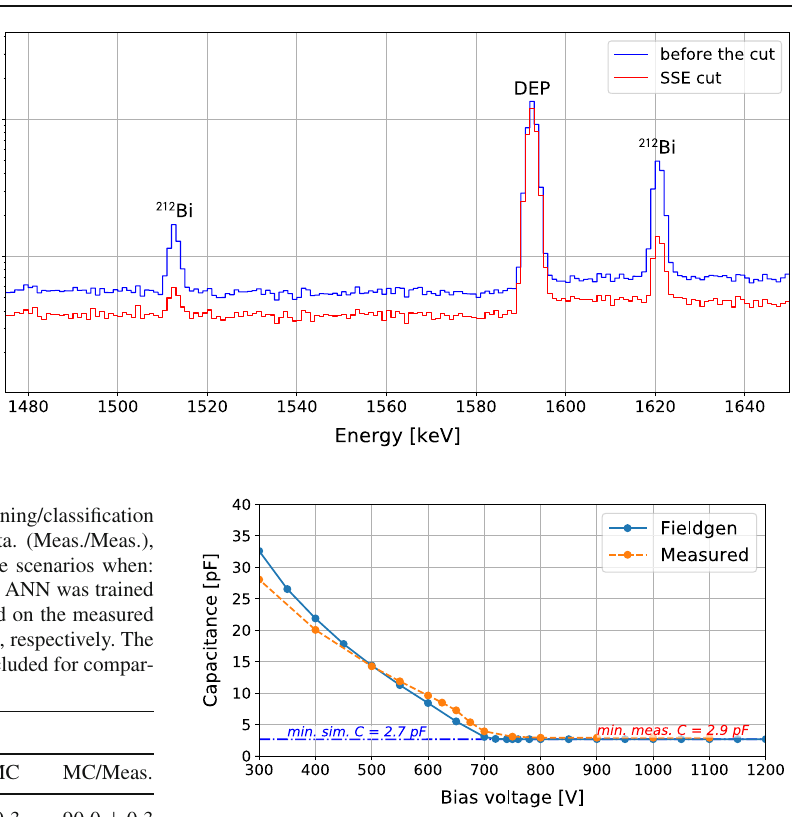
Fig. 24 ComparisonofthesimulatedandmeasuredC–Vcurvesforthe describedprototype.ThemeasuredcurveisthesameastheoneinFig.3. A good agreement between them can be observed for bias voltages over 500V, while for the voltages below this value the simulated capacitance is lower than the measured